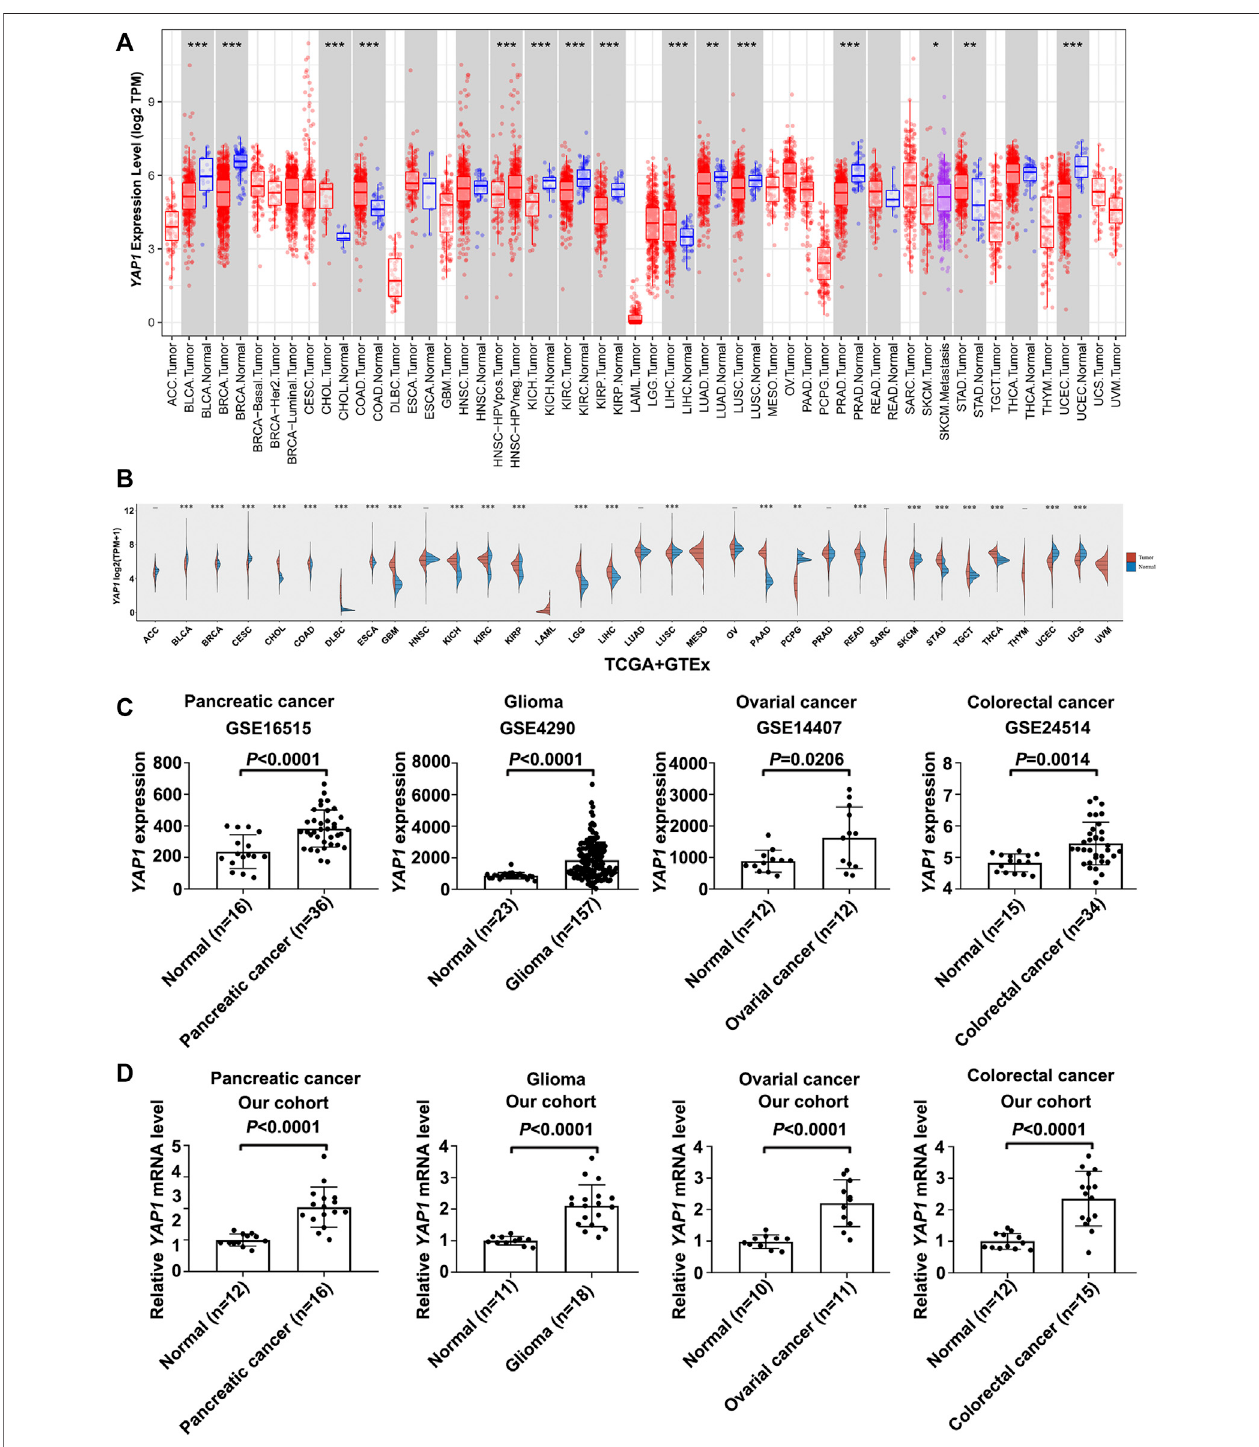
FIGURE 1 | The expression analysis of YAP1 in Pan-cancer. (A) The YAP1 expression in tumors and adjacent normal tissues in the pan-cancer data of the TCGA cohort. (B) The expression level of YAP1 in different cancer types from TCGA and GTEx data. The red spindle represents tumor tissue, and the blue spindle represents normal tissue. X axis, different tissue type. Y axis, YAP1 expression. * p < 0.05, ** p < 0.01, and *** p < 0.001. (C,D) The YAP1 mRNA expression in cancer tissues of four cancer types, including pancreatic cancer, glioma, ovarian cancer, and colorectal cancer were signi fi cantly overexpressed compared with normal tissues in GSE16515, GSE4290, GSE14407, and GSE24514 database (C) and in our cohorts (D) . Data were presented as mean ± SD and p -value was generated by Student ’ s t-test.